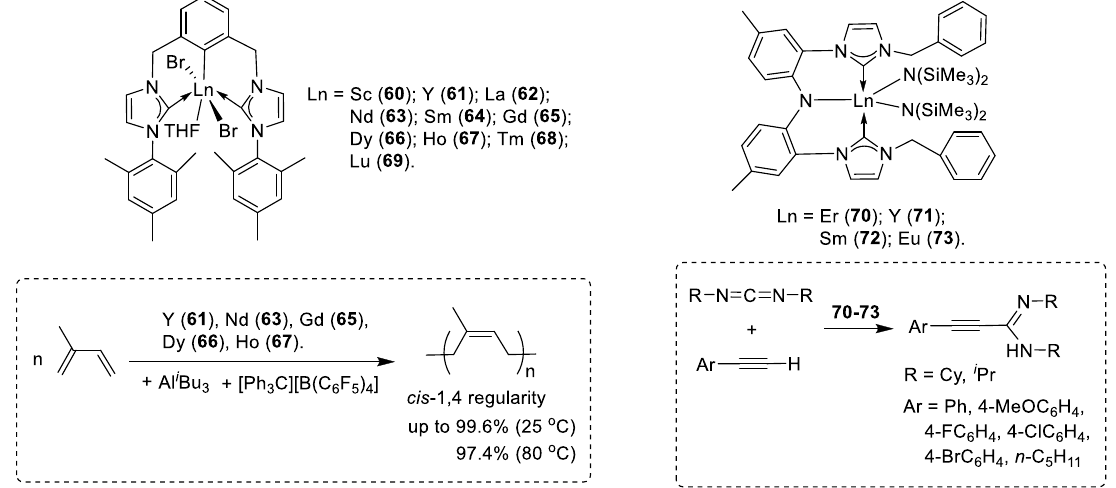
Figure 15. CCC- and CNC-pincer Ln complexes.